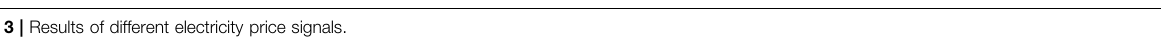
TABLE 3 | Results of different electricity price